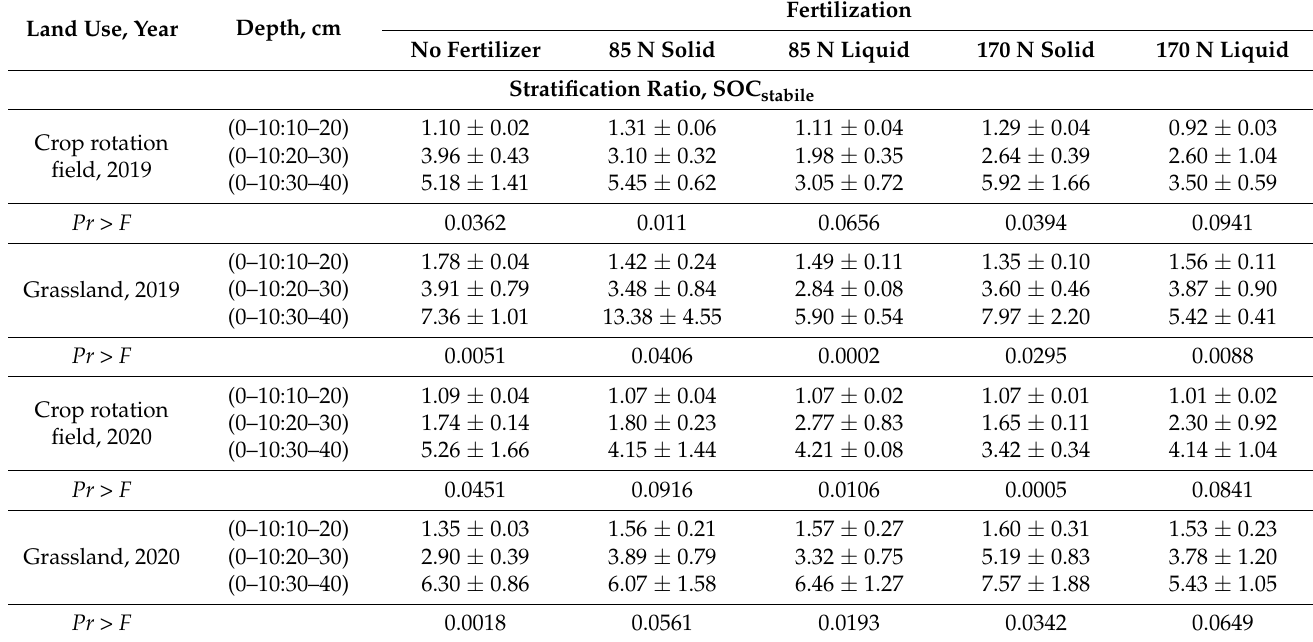
Table 2. Stratification ratio of stabile soil organic carbon (SOCstabile) ± standard error in digestate- treated soils under two land-use systems in 2019 and